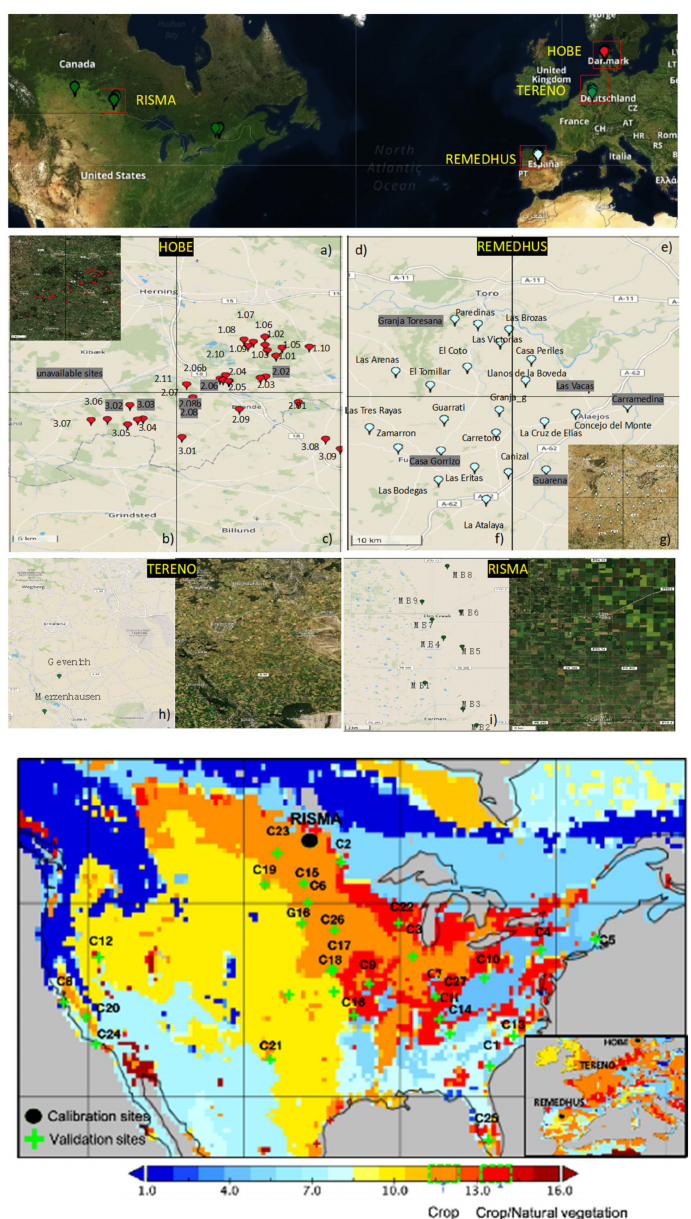
Figure A1. Map of ISMN (International Soil Moisture Network) sites [46] for calibration (upper panel), ( a – c ) for HOBE, ( d – g ) for REMEDHUS, ( h ) for TERENO, ( i ) for RISMA; and validation in USCRN sites (lower panel) over the IGBP (International Geosphere-Biosphere Programme) land classification based on MODIS measurements obtained from SMAP L4 (orange (IGBP 12): croplands and red (IGBP 14): cropland / natural